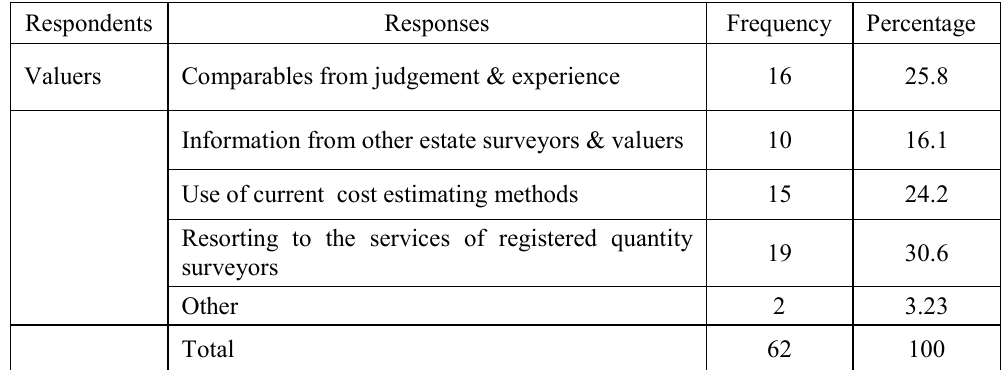
Table 1. Sources of Information on Reinstatement